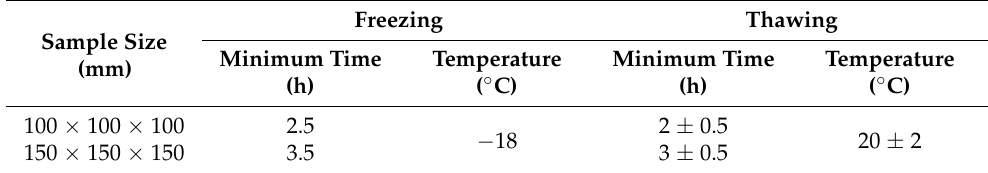
Table 5. Test conditions